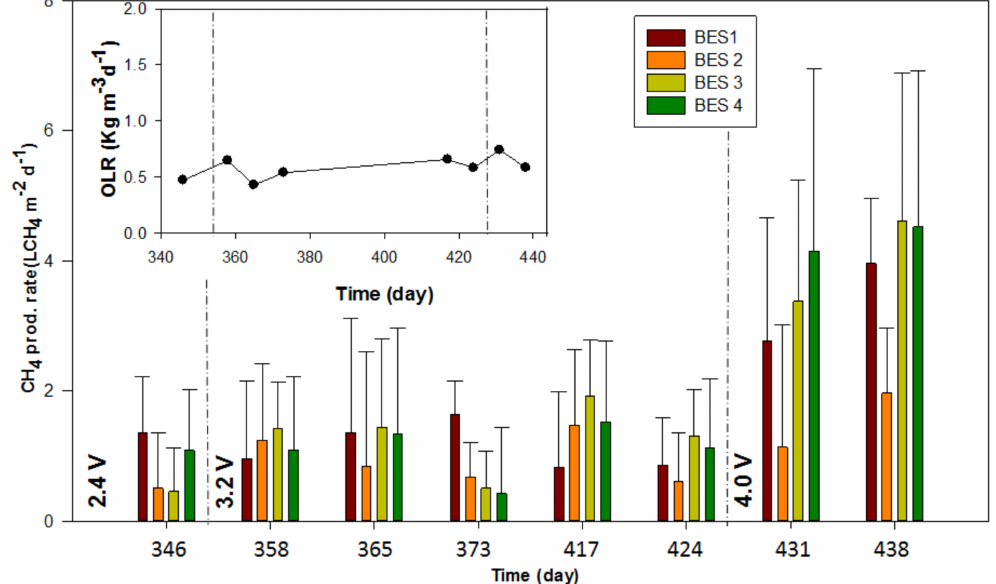
Figure 8. CH 4 production rate of series-connected EMG-BES at different stack voltages (2.4, 3.2 and 4.0 V). The sub-figure represents the applied organic loading rate